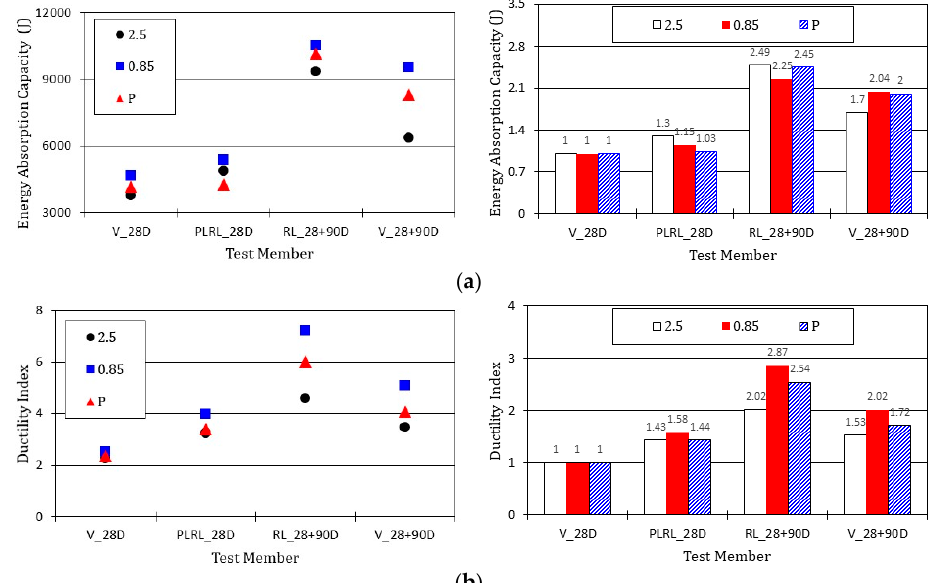
Figure 27. Comparison of energy absorption capacity and ductility index: ( a ) energy absorption capacity; ( b ) ductility index.